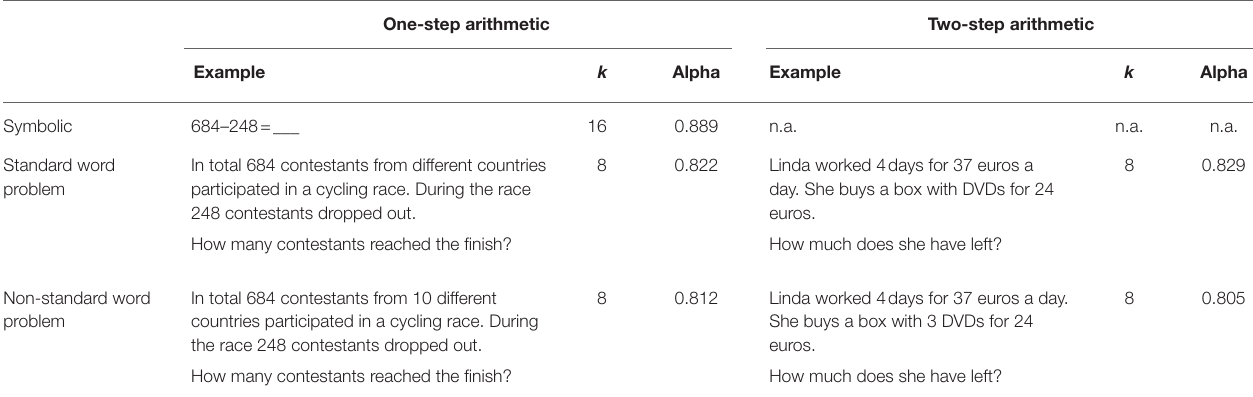
TABLE 1 | Overview of the arithmetic